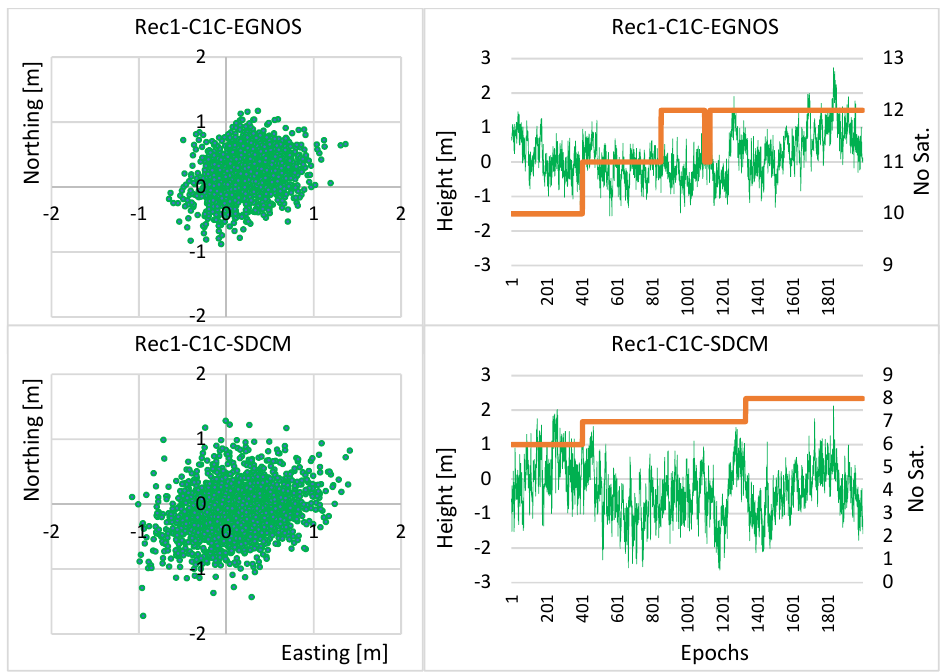
Figure 5. Real errors of horizontal and vertical coordinates of SBAS positioning based on C1C code, for the receiver Rec1 with EGNOS or SDCM corrections (Step II, see Figure 1).